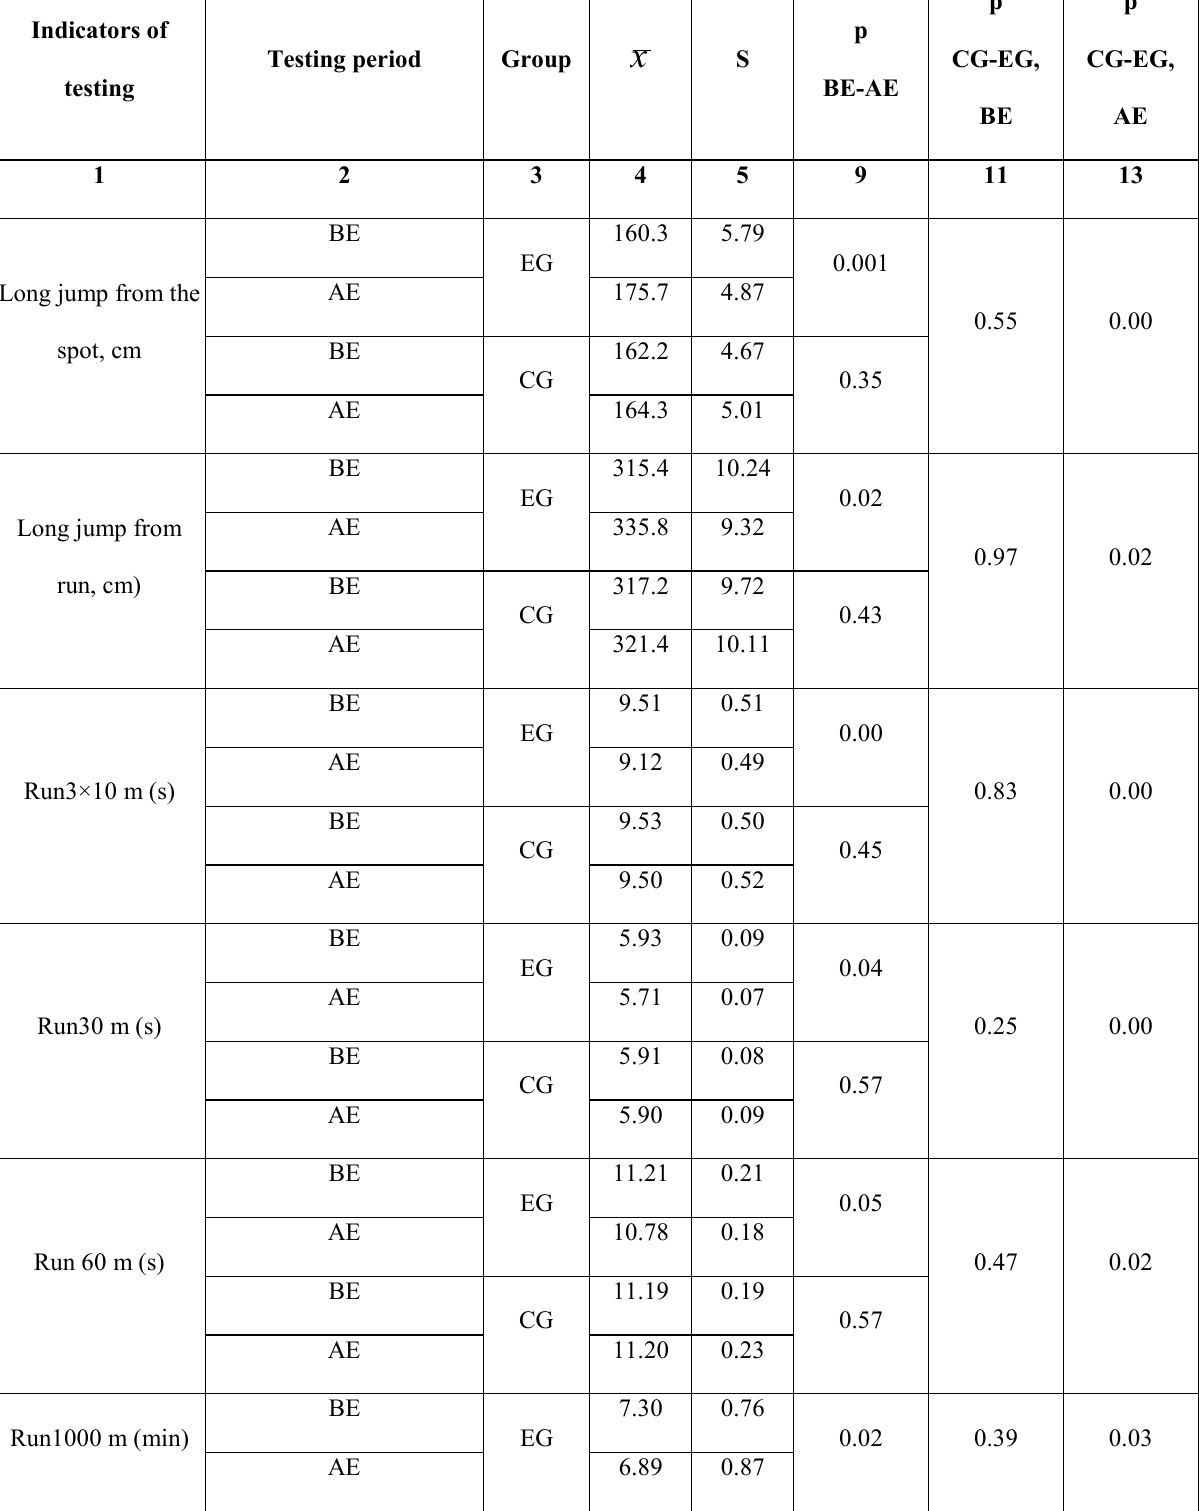
Indicators of light athletics’ motor skills, demonstrated by pupils of control (n=34) and experimental (n=33) groups before and after experiment (boys) групп